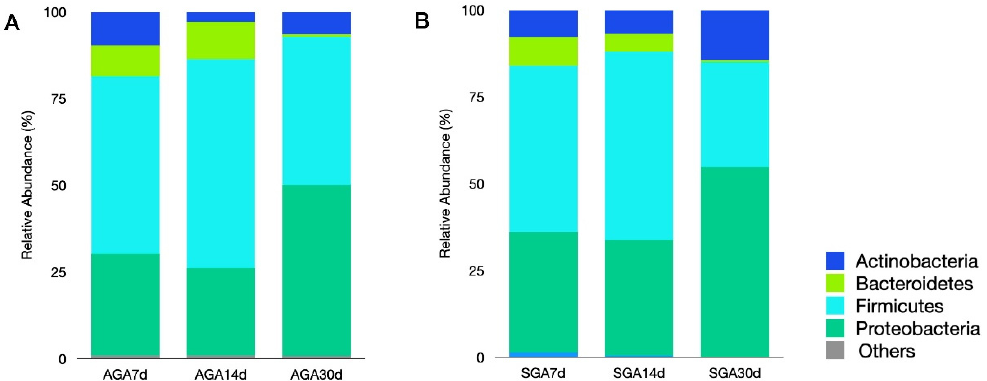
Figure 1. Relative abundance of dominant bacterial phyla in the AGA ( A ) and SGA groups ( B ) on days 7, 14, and 30. Abbreviations: AGA, appropriate for gestational age; SGA, small for gestational age.